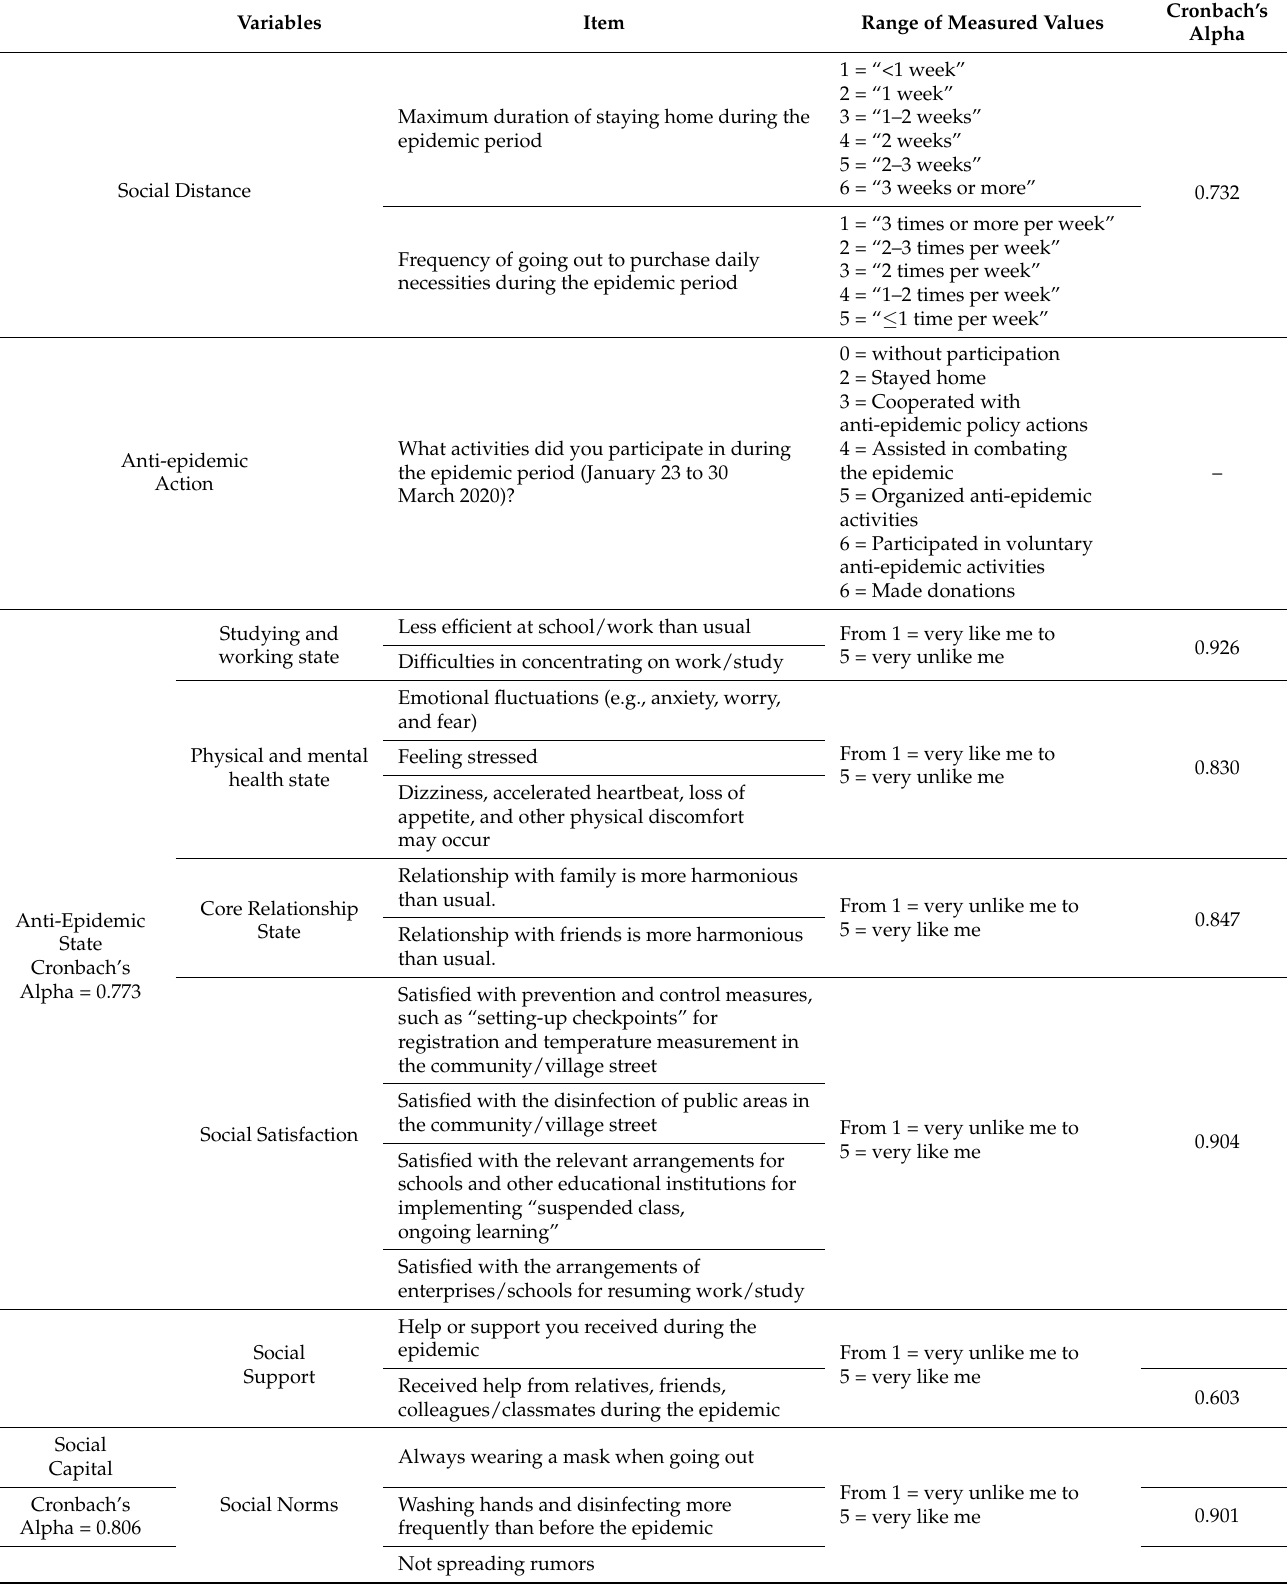
Table 1. Scales and